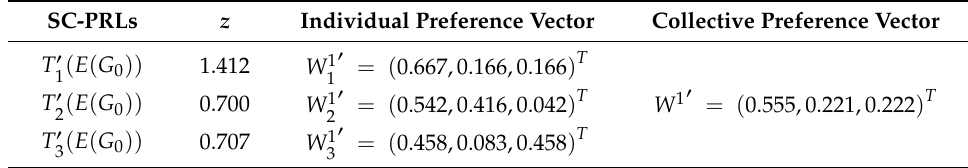
Table 4. Results of preference